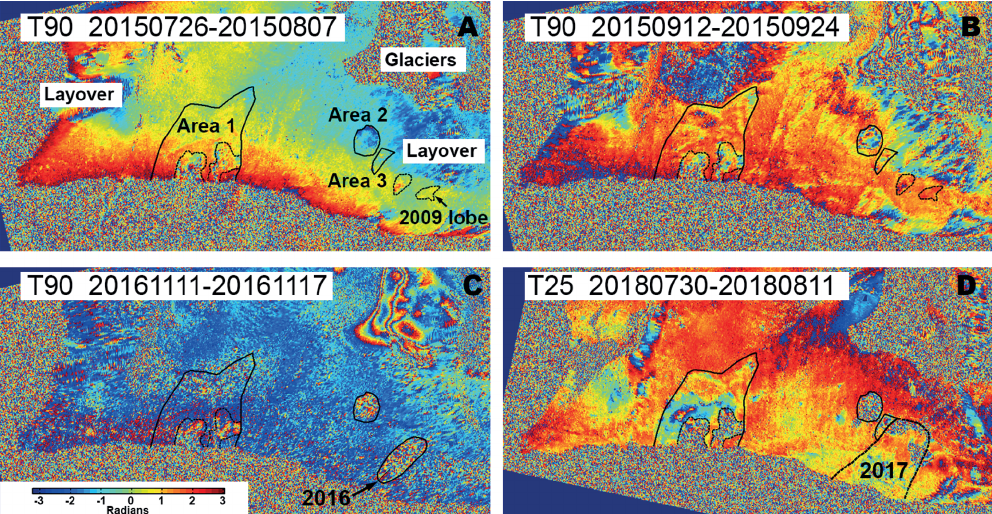
Figure 5. Two-pass interferograms of the eastern part of the Karrat Landslide Complex. The colours denote radar phase differences in the fundamental [- ππ ] interval, where one full interval of 2 π radians corresponds to 5.6cm of displacement. (a) Ascending track 90 during 26 June–8 July 2015. The deformation in the broader part of area 1 is not clearly seen in this viewing geometry; however, two subareas with decorrelation due to high deformation rates are apparent. Deformation in areas 2 and 3 and below the 2017 rock avalanche is visible, but the steep slope itself is in layover due to the geometry of the satellite acquisition. (b) Ascending track 90 during 12–24 September 2015. Area 2 shows decorrelation indicating acceleration of deformation rates. (c) Ascending track 90 during 11–17 November 2016, spanning the 2016 rock avalanche, which appears completely decorrelated. (d) Descending track 25 during 20 July–11 August 2018, a year after the 2017 rock avalanche. The area of the 2017 avalanche shows partly coherent and incoherent deformation. Areas 2 and 3 both show complete decorrelation due to high deformation rates. The upper right part of the interferograms shows varying coherent phase differences and decorrelation due to rapid movements of ice